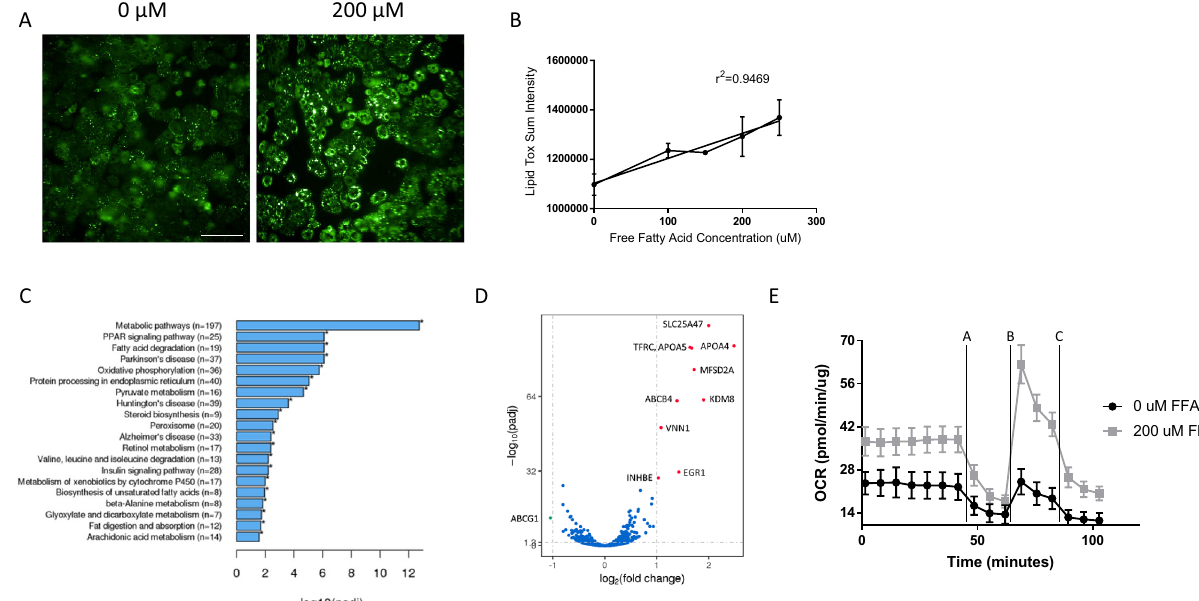
Figure 1. Characterization of human in vitro model of steatosis. ( A ) PHHs treated with 200 µM FFAs demonstrate a significant increase in neutral lipid content as demonstrated by LipidTox stain (green) (scale bar 100 µM). ( B ) LipidTox Sum intensity significantly correlates with FFA concentration (R 2 = 0.9469) ( C ) RNAseq enrichment analysis highlights key pathways disturbed following FFA treatment with fatty acid metabolic process being the most significantly impacted pathway. ( D ) A volcano plot describes the most significantly up (red) and down regulated (green) genes following exposure to FFAs. Dashed horizontal line indicates adjusted p-value of 0.05 while the dashed vertical lines represent twofold up and down regulation. ABCG1 is the most significantly upregulated gene and SLC25A47 is the most significant down regulated gene. ( E ) Mitochondrial stress test on the seahorse instrument highlights an increase in oxygen consumption rate in the presence of 200 µM fatty acids. Mitochondrial stress test involves the addition of oligomycin A (2.0 µM, time interval A), FCCP (2.0 µM, time interval B) and Rotenone Antimycin A (0.5 µM, time interval density (Fig. 2D) or viability (Fig. 2E). The ability of Gimeracil to prevent hepatocyte lipid burden was observed across three different lines of PHHs (data not shown), indicating this was not an artifact of a particular donor line, but a true biological phenomenon. The seahorse assay demonstrated that, in the presence of fatty acids, DPYD inhibition increased basal oxygen consumption with a maximal difference observed at 200 nm (adjusted p-value 0.0017) (Fig. 3A). At this dose level of Gimeracil, the mitochondrial stress test revealed increases in maximal respiration (adjusted p-value < 0.0001), spare respiratory capacity (adjusted p-value = 0.0008) and ATP production (adjusted p-value = 0.0002) (Fig. 3C) relative to 200 µM fatty acid exposure in the absence of Gimeracil. Thus, these results suggest perturbation of the pyrimidine catabolism pathway enhances mitochondrial functionality and fatty acid oxidation. RNAseq analysis revealed minimal changes to the transcriptome as a result of DPYD inhibition, but those genes with differential transcript expression levels (Fig. 4A) are key regulators of metabolic pathways, glycolysis, fatty acid degradation and glycerolipid metabolism (Fig. 4B). For example, the only differentially expressed tran- scripts, following exposure to 400 nM Gimeracil treatment in the presence of free fatty acids, were HSD17B13 , G0S2 , MID1IP1 , HMGCS1 , CYP2B7P1 , C19orf80 , SLC25A47 , and MALAT1 (Fig. 4A and all raw data were deposited to the Gene Expression Omnibus repository, GEO access number GSE201169). Fatty acid synthase ( FASN ) mRNA expression significantly decreased following Gimeracil exposure in both the presence and absence of FFAs (Table 1), with the most significant decrease observed for the highest dose of Gimeracil, (adjusted p-value 0.0123 and < 0.0001 for vehicle and FFA exposure, respectively). While FASN mRNA expression decreased following FFA exposure in the absence of Gimeracil, the change was not signifi- cant (adjusted p-value 0.0607; Table 1). The G0/G1 Switch Gene 2 ( G0S2 ), a master regulator of hepatic lipid content through its inhibition of lipolysis 19 , mRNA expression increased following exposure to FFAs (adjusted p-value = 0.0016, Table 1) and decreased following exposure to Gimeracil (at the highest dose of 400 nM) in both the presence and absence of FFAs (adjusted p-value of 0.0123 and 0.0095, respectively; Table 1). 3-Hydroxy- 3-Methylglutaryl-CoA Synthase 1 ( HMGCS1 ), a rate-controlling enzyme in cholesterol biosynthesis, mRNA expression increased following exposure to FFA (adjusted p-value of 0.005; Table 1) and decreased in the pres- ence of FFA at both the 200 and 400 nM dose of Gimeracil (adjusted p-value of 0.0001 and < 0.0001, respectively; Table 1). The hepatic lipid droplet protein hydroxysteroid 17-beta dehydrogenase 13 ( HSD17B13 ) mRNA expression was significantly down-regulated at all dose levels of Gimeracil, in both the presence (adjusted p-values ≤ 0.0212 for all three dose groups; Table 1) and absence (adjusted p-values < 0.001 for all three dose groups; Table 1), of FFA treatment. MID1 interacting protein 1 (MID1IP1) regulates hepatocyte lipogenesis through its regulation of